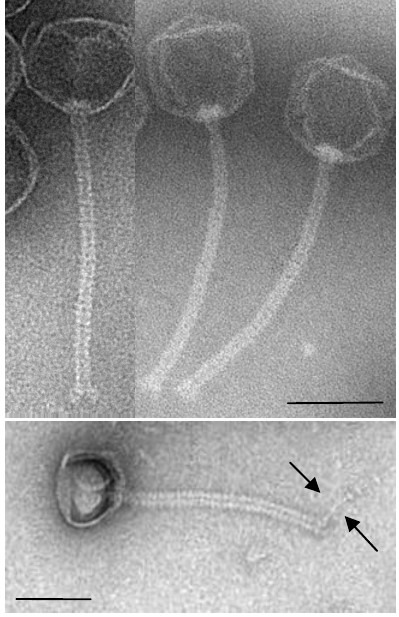
Figure 1. Transmission electron micrographs of TP21-L virions negatively stained with 2% uranyl acetate or 2% ammonium molybdate. The bar represents 50 nm. A putative tail fiber structure is indicated by